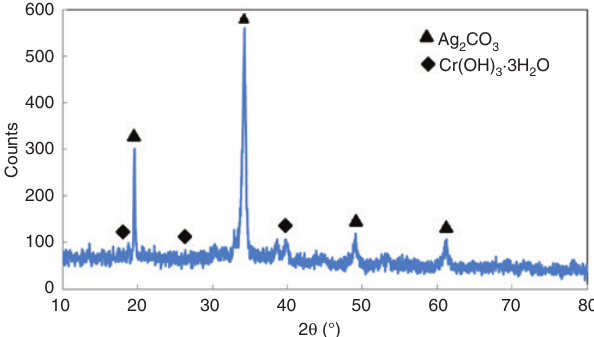
Figure 1: XRD pattern of the initial precipitates.